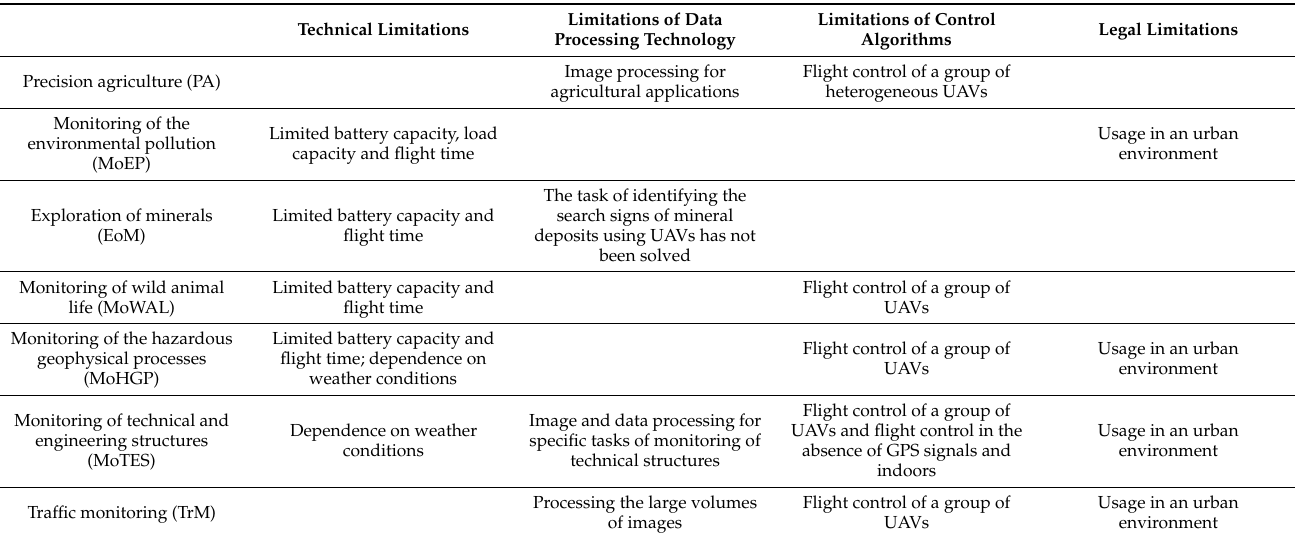
Table 3. The influence of the limitations of the IUAVT technology on the solution of problems in the sectors of